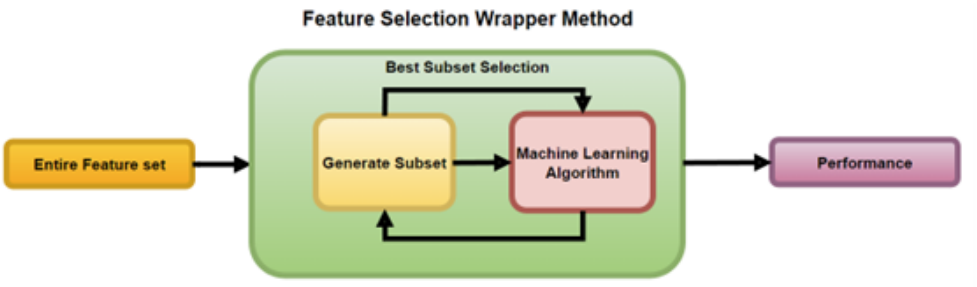
Figure 6. Process of the Feature Selection Wrapper Method Mehta et al. [13] and Shamsud- deen et al. [26].